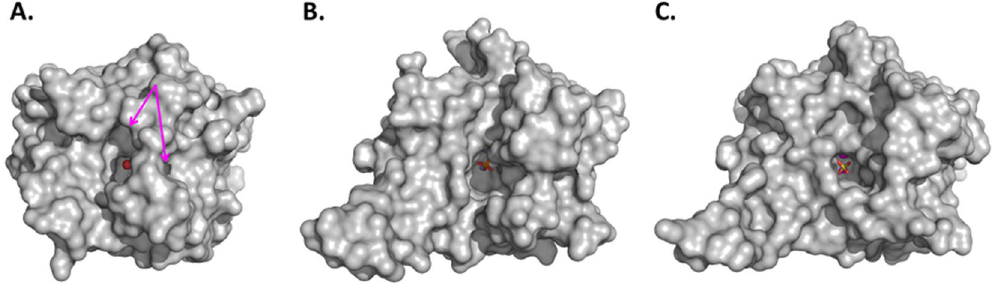
Figure 5. Active site accessibility in three different MLLs. ( A ) AiiA (PDB: 2A7M) active site cavity appears divided in two parts by two residues (F68 and E135), indicated by pink arrows. ( B ) AiiB (PDB: 2R2D) active site cavity. AiiB is bound to a phosphate molecule shown as orange sticks. ( C ) AaL (PDB: 6CGY) active site is bound to a phosphate molecule shown as orange sticks. Active site metal cations are shown as red spheres.